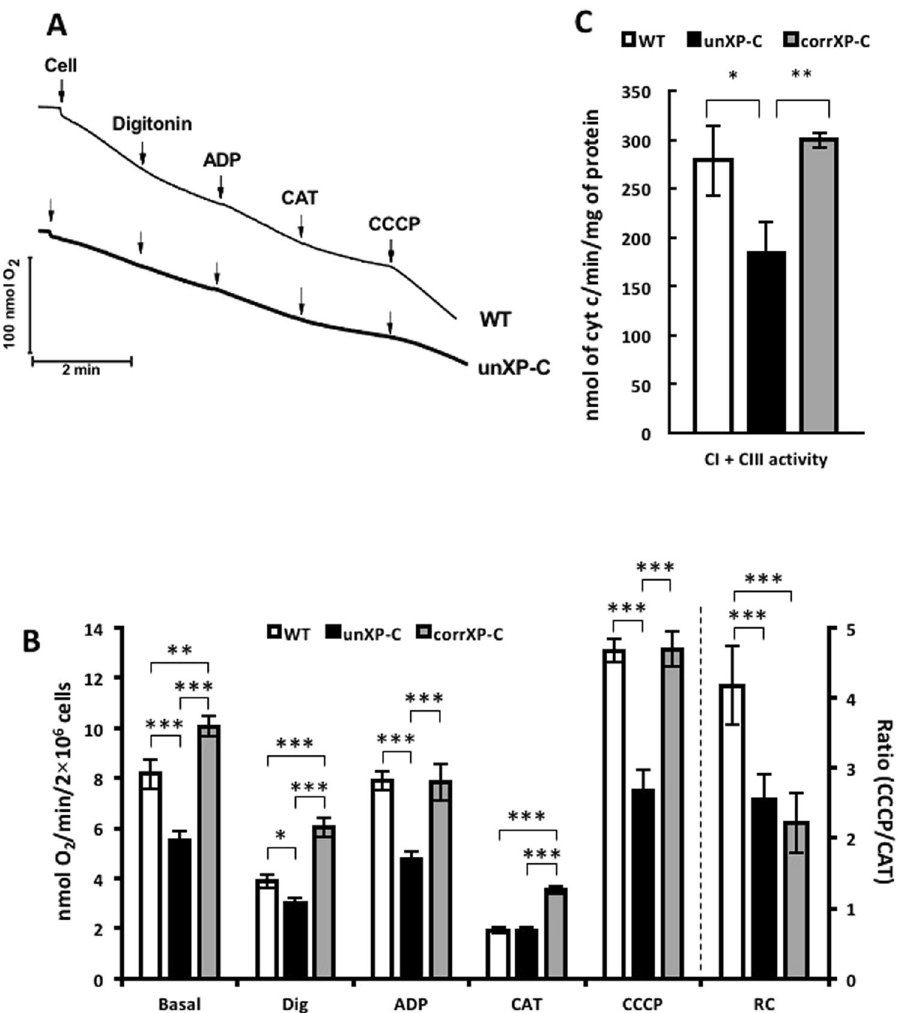
Figure 1. Complex I-supported mitochondrial function is impaired in XP-C cells. ( A ) O 2 consumption for MRC-5 (WT), XP4PA (unXP-C) and XP4PA expressing XPC (corrXP-C) was measured as described, using 4 × 10 6 cells in standard reaction medium containing 5 mM CI substrate, with the subsequent additions of 30 µ M Digitonin, 100 µ M ADP, 4 µ M CAT and 1 µ M CCCP. The figure shows a representative trace OCR experiment. ( B ) The rates of O 2 consumption and respiratory control (RC, ratio between CCCP/CAT) were calculated from data obtained in the experiments represented in ( A ). ( C) CI + CIII activity was measured using 5 µ g of crude mitochondrial protein. Reduction of cyt c was monitored at 550 nm at 37 °C for 5 min. For the calculations, only the region where the slopes of the reactions were linear were considered. The data represent mean ± SD of 4 independent experiments. * p < 0.05, ** p < 0.01 and *** p <